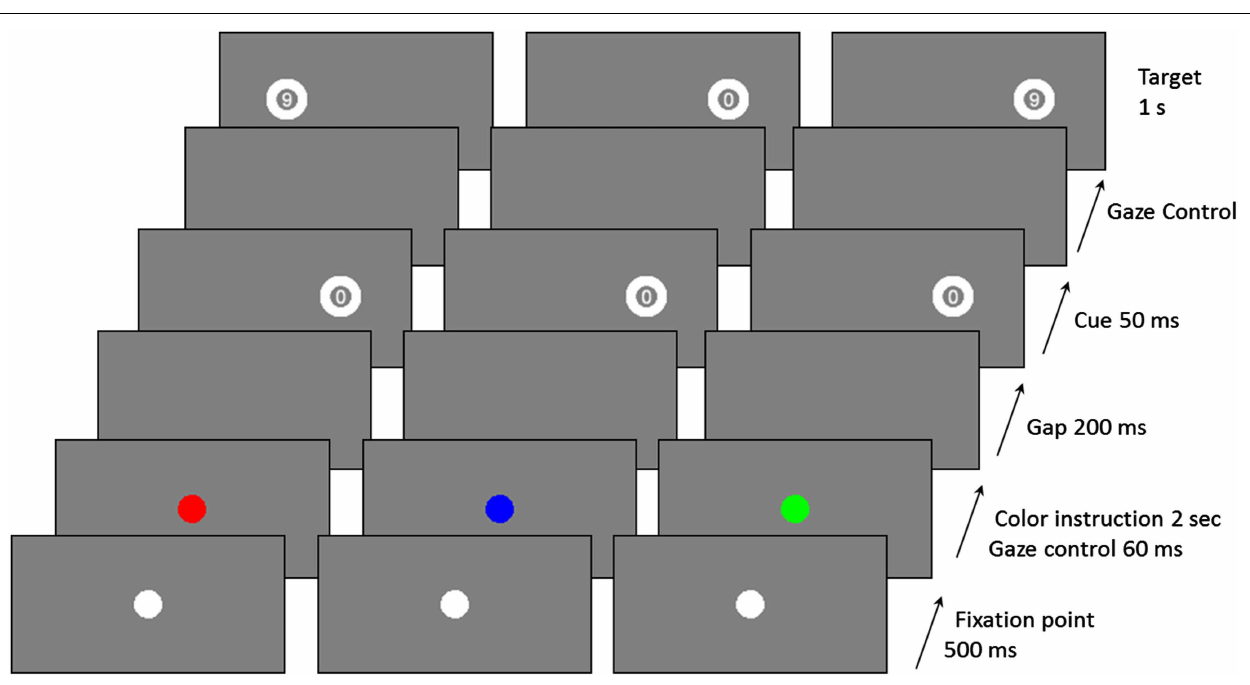
FIGURE 1 | Examples of trial sequences for the three saccadic conditions (red:AS, Blue: NS, and green: PS).